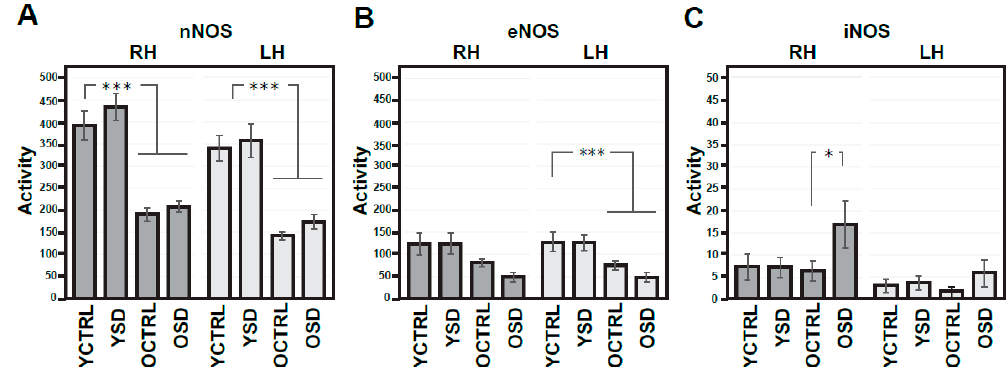
Figure 5. Activities of NO synthases in the right and left parietal cortex of young adult and old rats exposed to acute sleep deprivation. Activities of various NOS isoforms ( A – C ) expressed as nmoles / 30 min / mg of proteins. Results are presented as means ± SEM. Statistical significance (Student’s t -test) was calculated with respect to young adult or old controls (* p < 0.05, *** p < 0.001). RH—right hemisphere, LH—left hemisphere, nNOS—neuronal NOS, eNOS—endothelial NOS, iNOS—inducible NOS, SD—sleep deprivation, YCTRL—young adult controls ( n = 12), YSD—young adult rats exposed to acute SD ( n = 12), OCTRL—old controls ( n = 12), OSD—old rats exposed to acute SD ( n = 12).